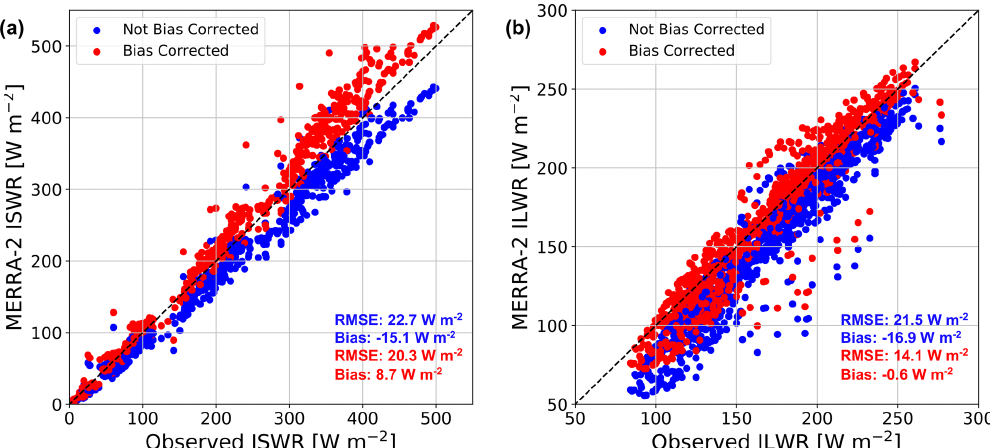
Figure A1. MERRA-2 incoming shortwave and longwave radiation bias correction. Comparison between monthly averaged AWS-observed and MERRA-2-modeled incoming shortwave radiation (a) and longwave radiation (b) at nine automatic weather stations. Non-bias-corrected MERRA-2 radiative fluxes are shown in blue while bias-corrected fluxes are shown in red. Mean MERRA-2 root-mean-square error (RMSE, Wm − 2 ) and bias (Wm − 2 ) are shown in blue and red text for non-bias-corrected and bias-corrected radiative fluxes, respectively. The dashed black line represents a one-to-one